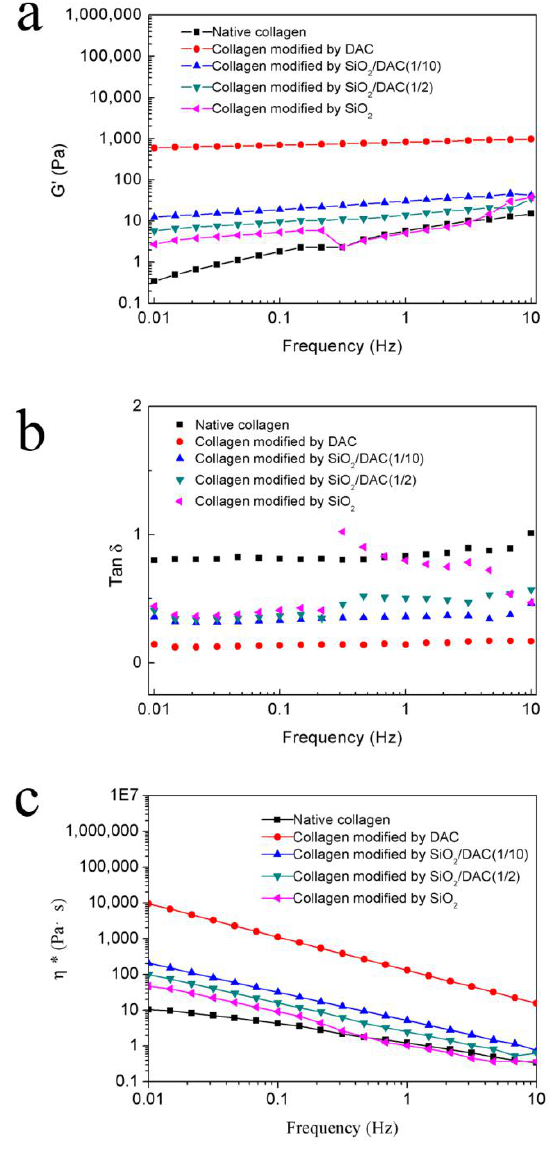
Figure 8. G’ ( a ), tan δ ( b ) and η* ( c ) of native collagen and collagen cross-linked by the SiO 2 /DAC hybrid materials.